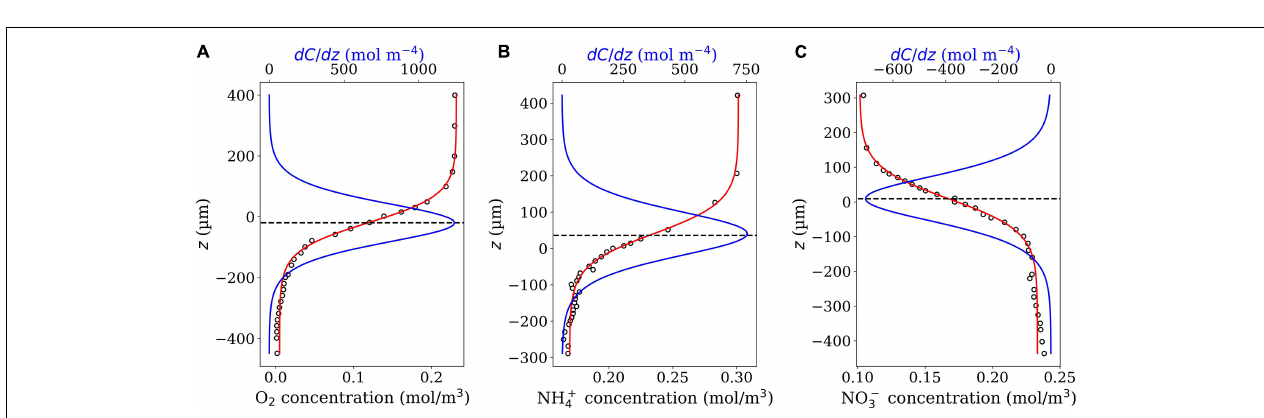
FIGURE 8 | Oxygen (A) , ammonium (B) and nitrate (C) microprofiles (close circles) measured in nitrifying bacterial aggregates. Data were digitalized from Figure 3 in de Beer et al. (1993). The obtained z values were multiplied by –1 setting the positive direction of z -axis upwards. As seen, Eq. 4 properly fits all the three profiles (red curves) and the picks of the corresponding derivative function, Eq. 5 (blue curves) occur around z = 0, the position at which the interface has been identified in the original study. Note that, in contrast to the cases of oxygen and ammonium, the nitrate concentration increases gradually going from the bulk water towards the aggregate center, and that is why the values of the derivative function is negative for the nitrate microprofile.